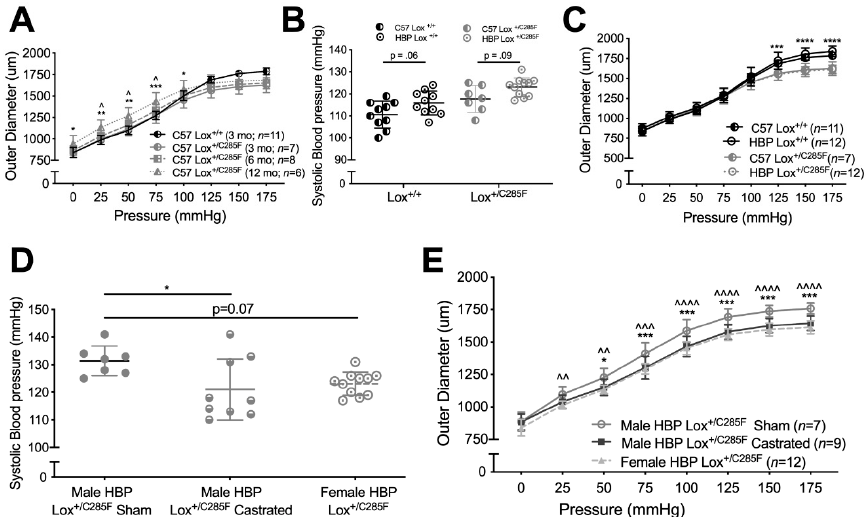
Figure 3. Sex effects of Lox +/C285F . ( A ), Female C57 Lox +/C285F show no increase in diameter at 6 months relative to 3 months and only begin to show dilation by 12 months (* p values for 3 vs. 12-month C57 Lox +/C285F and ^ p values for 6 vs. 12-month C57 Lox +/C285F by two-way ANOVA, Tukey). ( B , C ), When bred to HBP, SBP was modestly increased (( B ), p < 0.001 for blood pressure effect and p < 0.01